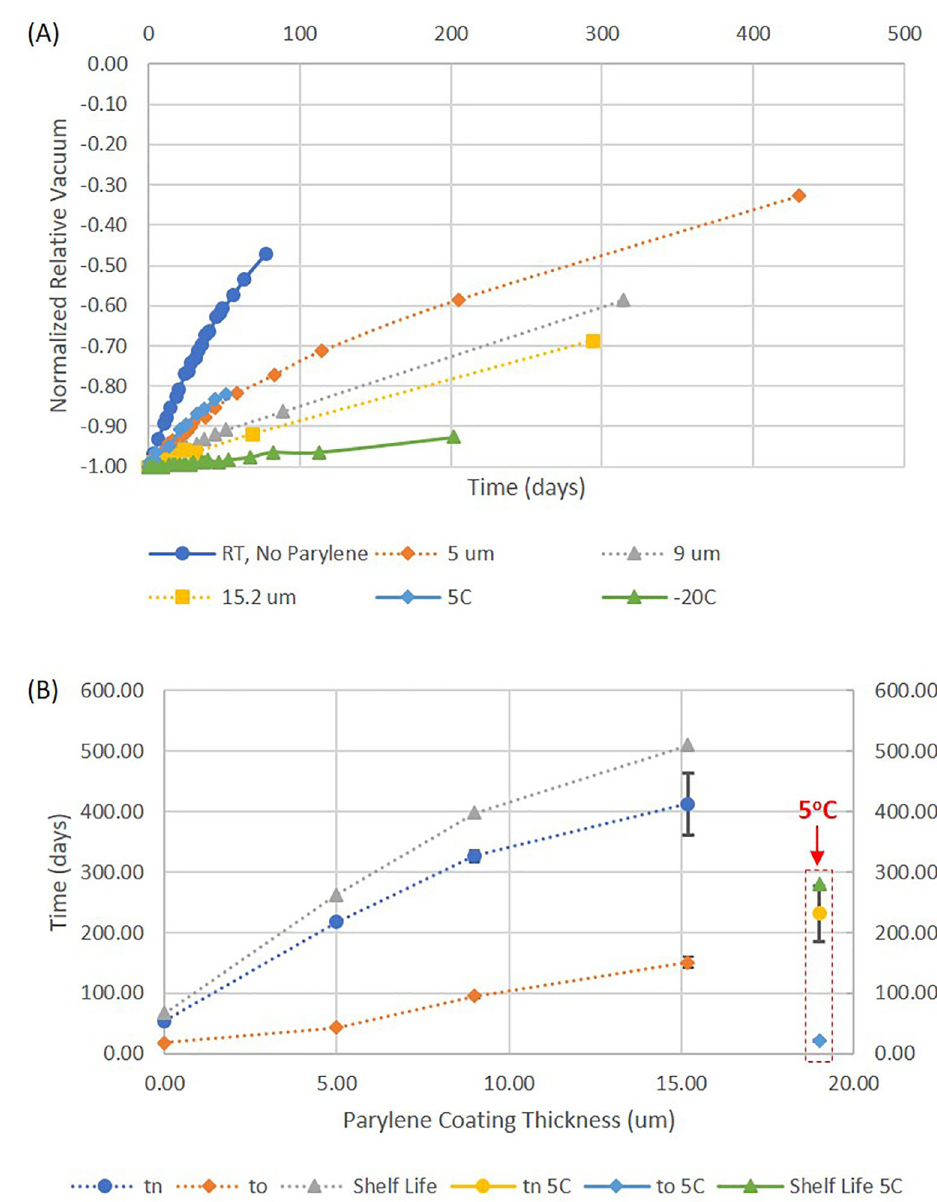
Fig 4. VacuStor tube vacuum shelf life study. (A) Change of normalized relative vacuum over time for VacuStor tubes under different conditions (Performance of one tube out of three replicates was plotted for each condition); (B) Means and standard deviations of nitrogen, oxygen leaking time constants for different Parylene coating thicknesses; the values for 5˚C were also plotted for comparison. Three tubes were analyzed for each condition. Shelf lives were calculated using the mean